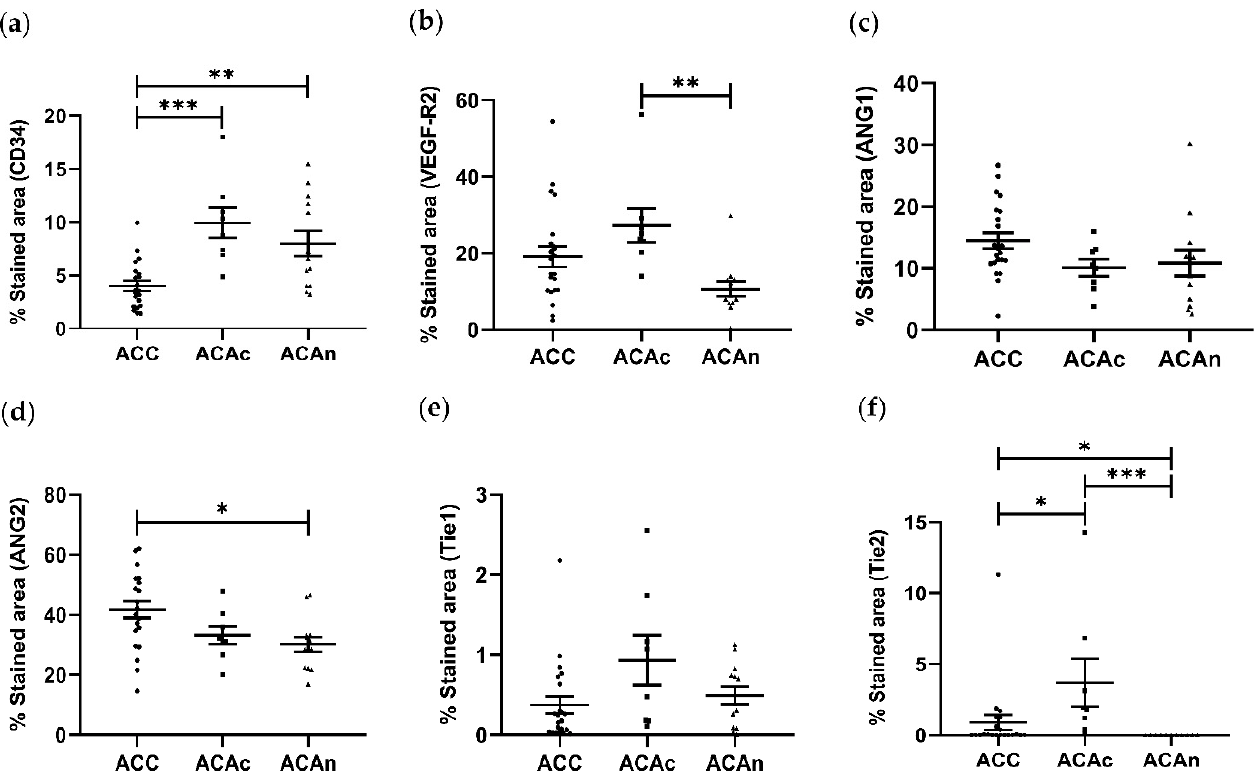
Figure 2. Distribution of the stained area for CD34 ( a ), VEGF-R2 ( b ), Ang1 ( c ), Ang2 ( d ), Tie1 ( e ) and Tie2 ( f ) in adrenocortical carcinoma (ACC), adrenocortical adenoma with Cushing syndrome (ACAc) and non-functioning adrenocortical adenoma (ACAn). (ANOVA or Kruskal–Wallis test: * p < 0.05, ** p < 0.01 and *** p < 0.001) .